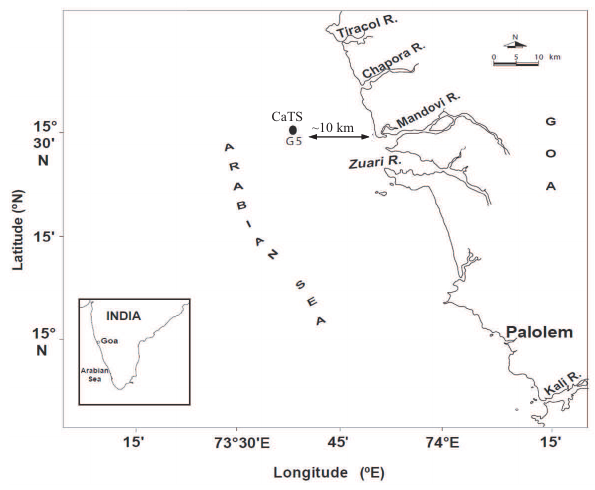
Fig. 1. Map of the study area showing the location of Candolim Time Series (CaTS) station (G5) off